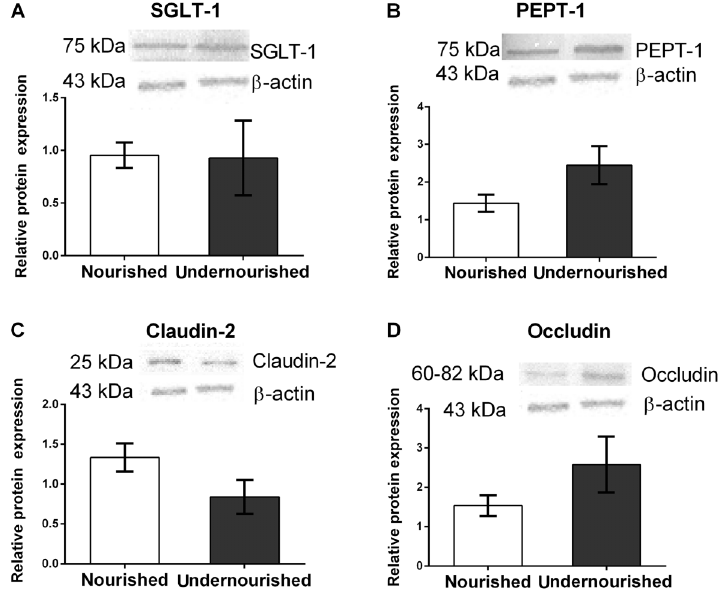
Figure 7. Effect of regional basic diet on protein expression of intestinal transporters and tight junctions. A , SGLT-1; B , PepT-1; C , claudin-2; D , occludin. Data are reported as means ± SE (n=4). P 4 0.05, Mann-Whitney